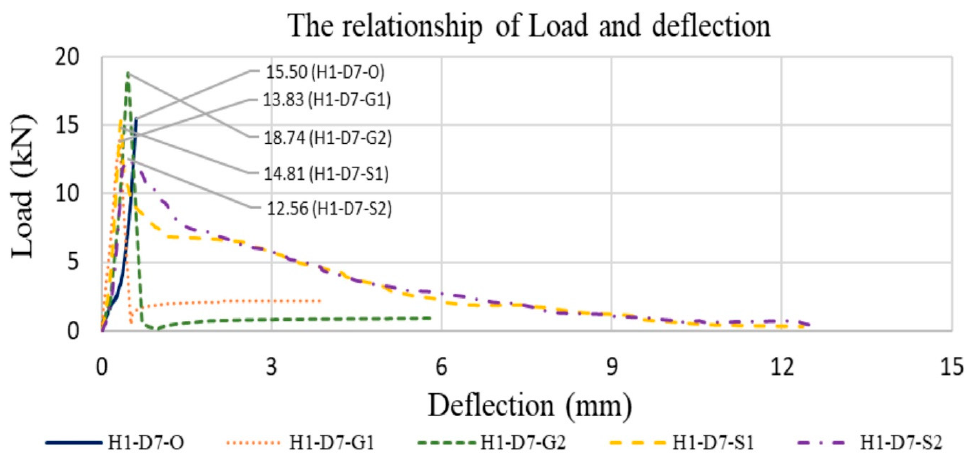
Figure 17. Flexural load and displacement diagram for H1 high-strength fiber pervious concrete.